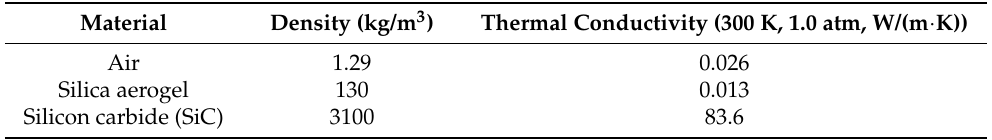
Table 1. Materials and